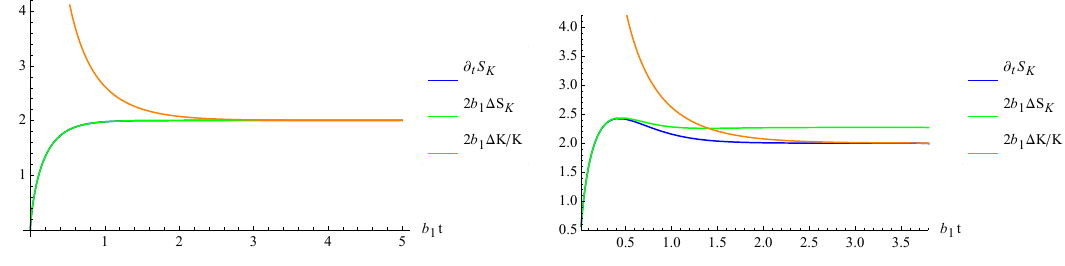
Figure 2 . Entropy growth for SYK model. Left panel: ξ = 1 . The bound ∂ t S K = 2 b 1 ∆ K/K is approached from below in the long time limit and ∂ the evolution, the dispersion bound is always saturated and ∂ (but long) times. Right panel: ξ = 2 . The bound ∂ but the relation (4.20) can be extended to finite times t ≥ t